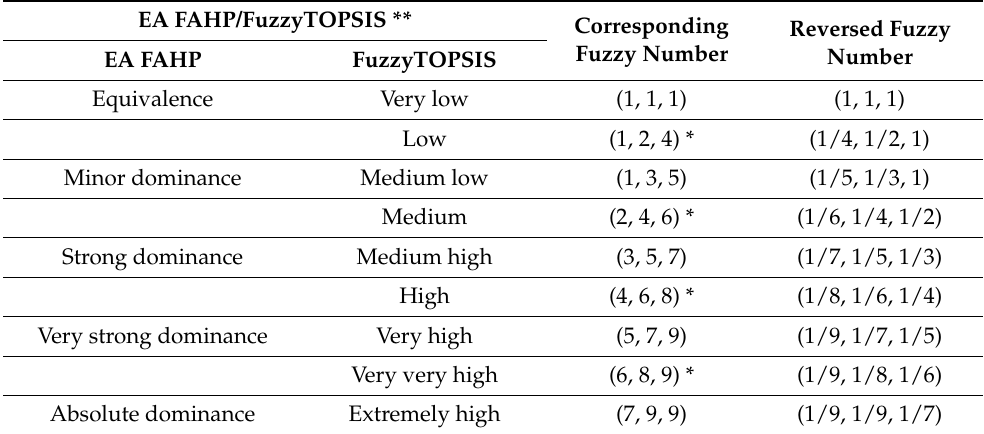
Table 6. Linguistic scales and corresponding scales used in EA FAHP and FuzzyTOPSIS methods, developed based on [56,58,61].